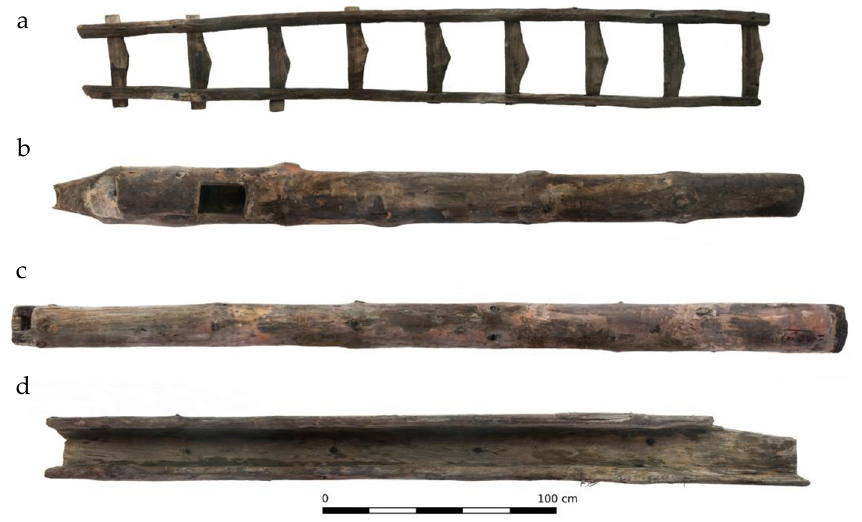
Figure 8. Wooden elements from a paternoster pump, where ( a ) ladder and the mine drainage system: ( b ) and ( c ) pipes, and ( d ) trough.